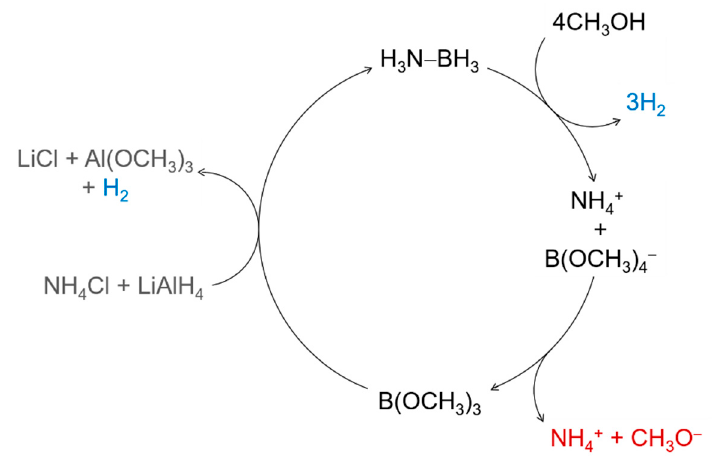
Figure 7. A way to close the hydrogen cycle with the couple ammonia borane–methanol, provided that a single by-product forms (Equation (17)).